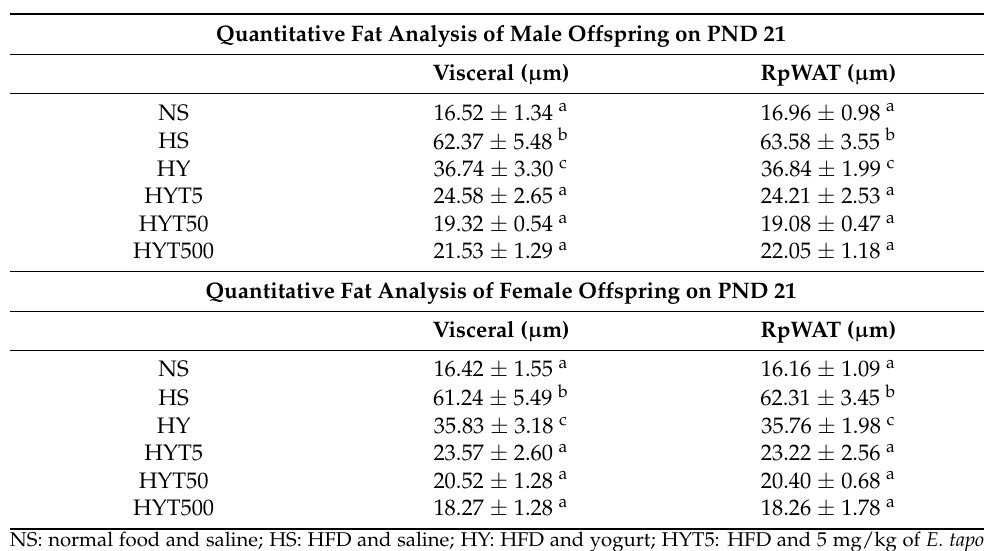
Table 5. Quantitative analysis of fat hypertrophy of male and female offspring on PND